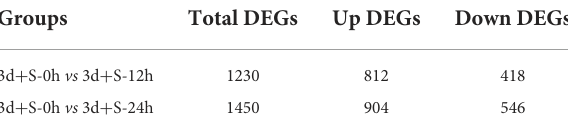
TABLE 4 The number of differentially expressed genes